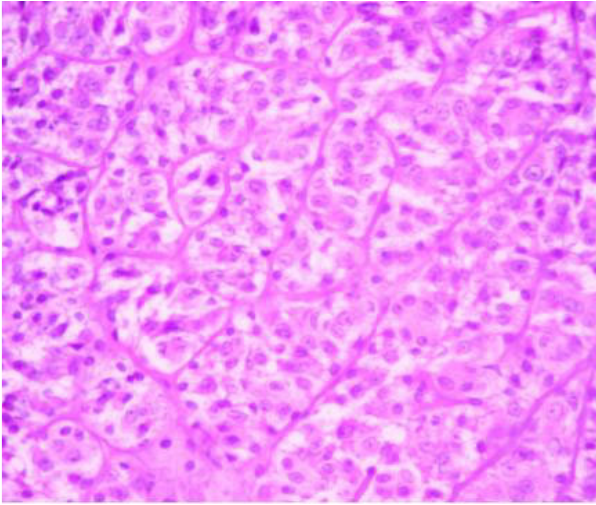
and round to ovoid nucleus (H & E staining, 400X).